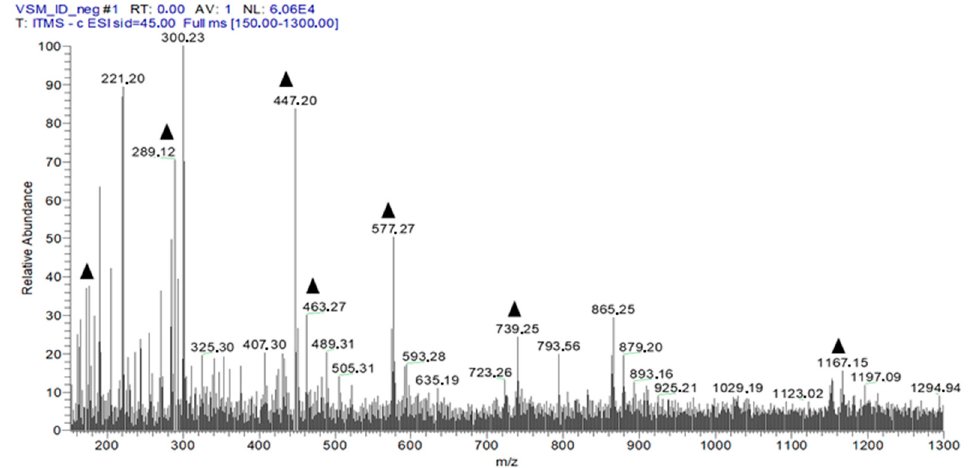
Figure 3. First-order spectrum of direct flow injection analysis (FIA-ESI-IT-MS) obtained in the negative mode for EHVG. ( (cid:78) ) Fragments of the chemical compounds identified.